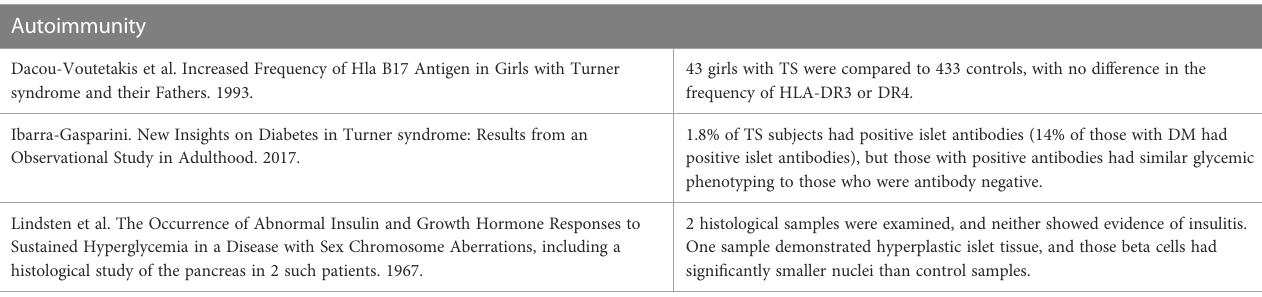
TABLE 3 Summary of key studies evaluating autoimmunity as a potential mechanism contributing to TS-associated hyperglycemia.